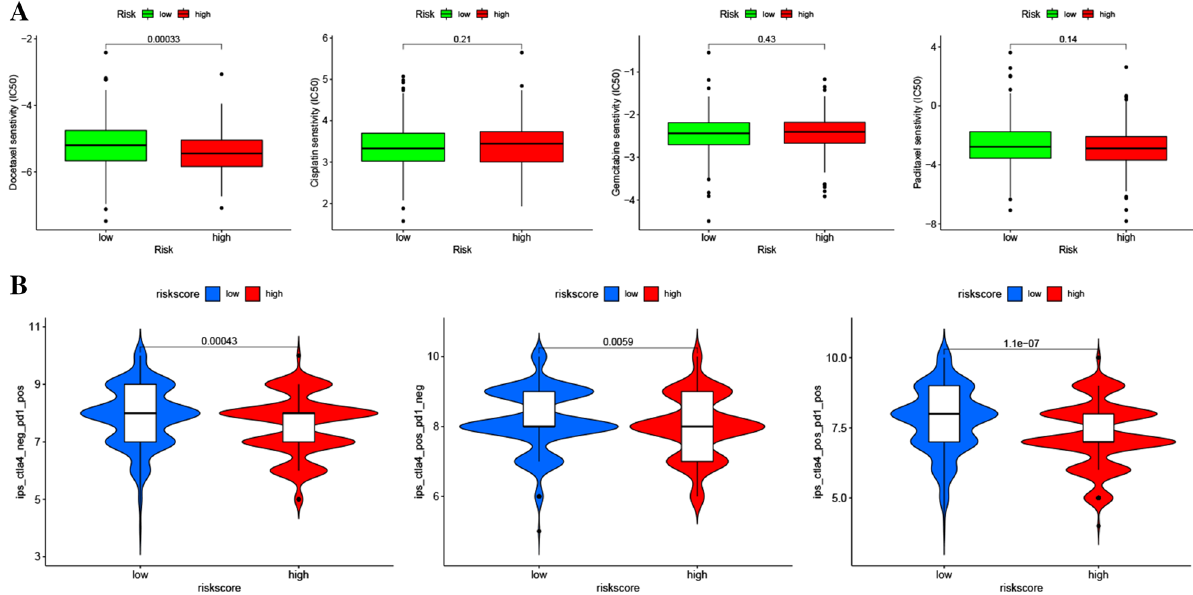
Figure 8. The predictive effects of the rrlncRNAs signature for chemotherapeutic drugs ( A ) and immune checkpoint inhibitors ( B